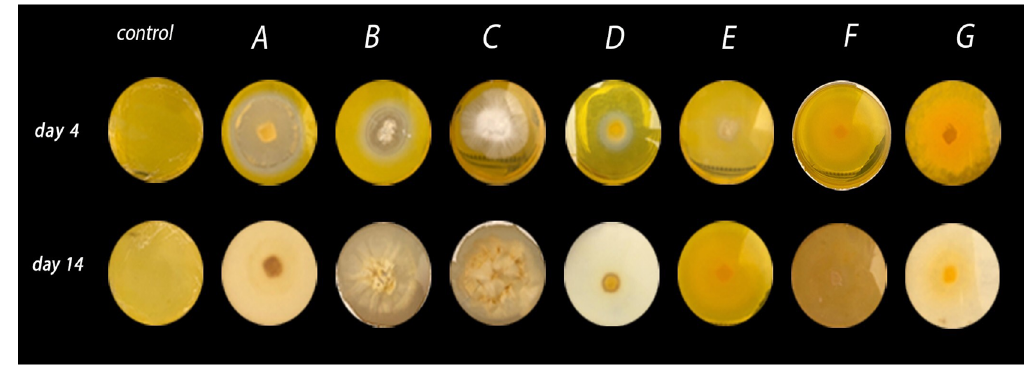
Figure 1. β , β -carotene biotransformation after a 4- and 14-day incubation periods. Screening was conducted using seven strains of native basidiomycetes—namely, Ganoderma stipitatum ( A ), Ganoderma chocoense ( B ), Ganoderma gibbosum ( C ), Ganoderma weberianum ( D ), Laetiporus gilbertsonii ( E ), Trametes elegans (endophyte) ( F ), and Trametes elegans ( G ). Table 2. Concentration of cis -Verbenol (mM) noted during the biotransformation of α -pinene using the whole cells of T. elegans (ET-06 and EBB-046) in a 48-h reaction period. dwm: dry weight mass. Concentration of cis -Verbenol (mM) Cell concentration (g dwm L − 1 )